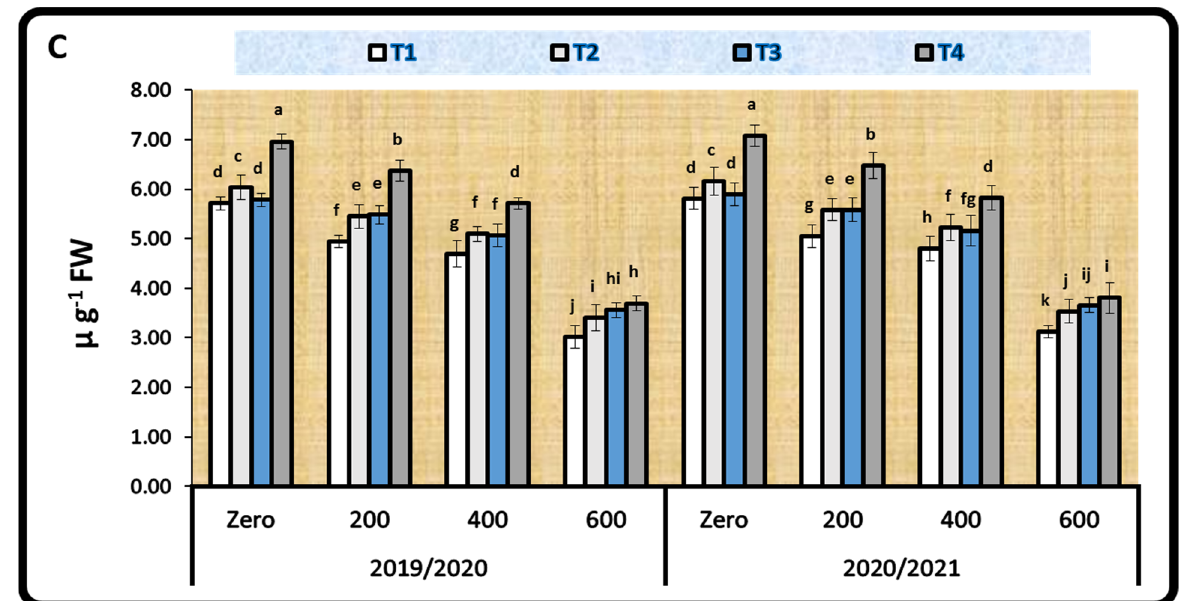
Figure 2. Effect of different concentrations of Ni and bacterial inoculation on total chlorophyll ( A ), carotenoids ( B ), and TSS ( C ) in faba bean leaves at 60 days after sowing during the 2019/2020 and 2020/2021 seasons. a–k: Duncan’s letters.